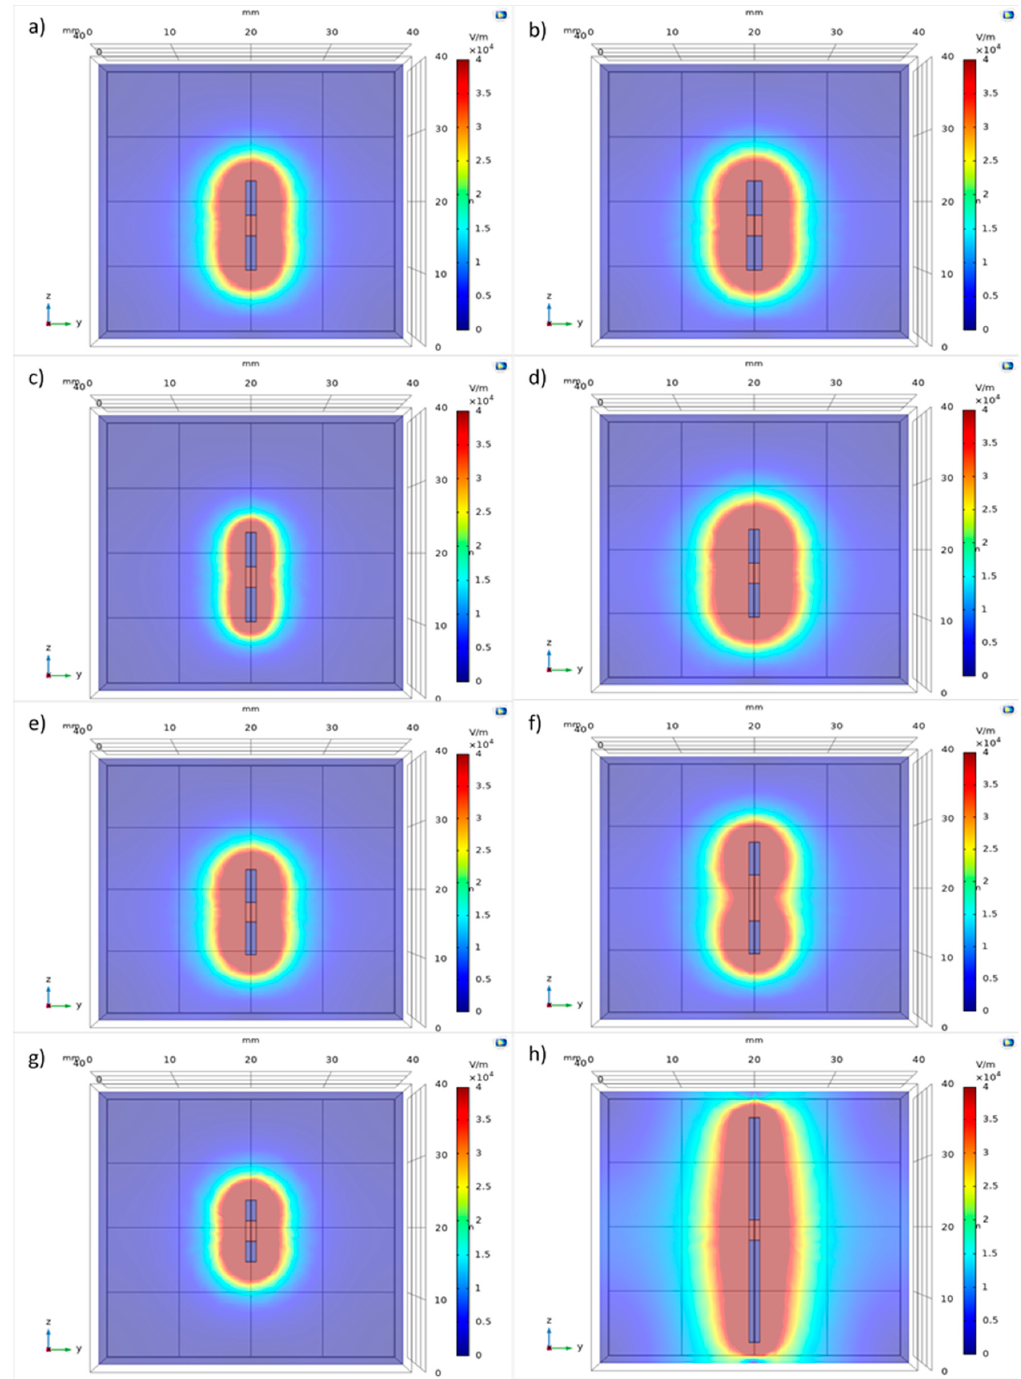
Figure 1. The electric field distribution simulated with Comsol Multiphysics ® . Field distribution due to an electrode diameter of 1.40 and of 2.0 mm is respectively shown in ( a ) and ( b ). Field distribution due to an applied voltage of 500 and of 1500 V is respectively shown in ( c ) and in ( d ). Field distribution due to an insulated pole of 3.00 and of 7.00 mm is respectively shown in ( e ) and in ( f ). Field distribution due to a length of both the conductive poles of 3.00 and of 15.00 mm is respectively shown in ( g ) and in ( h ). The color bar represents the intensity of the electric field distribution: in red is the highest value of electric field of the electroporated zone that decreases when moving away from the poles of the electrode.